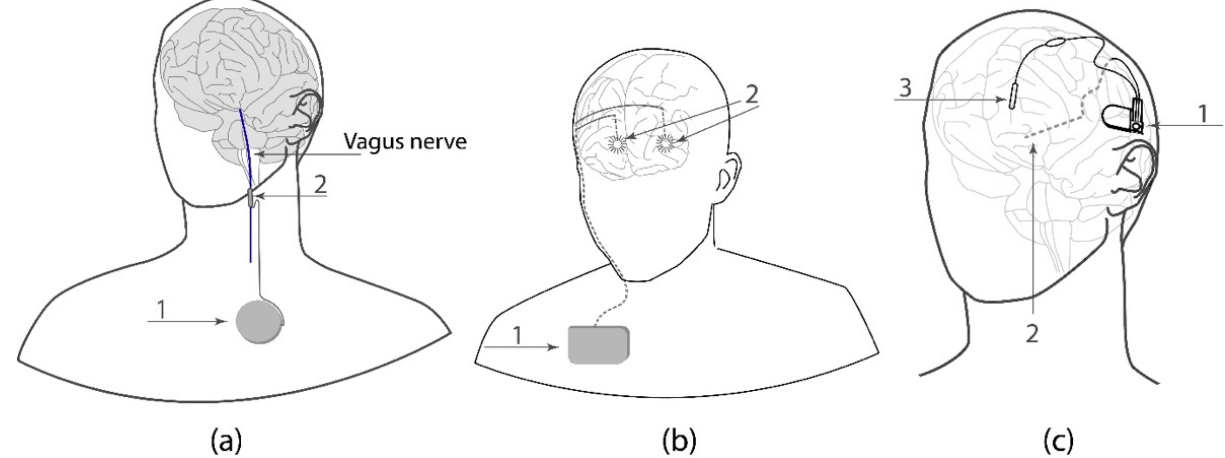
Figure 1. The schematic illustration of brain-machine interface prototypes to suppress epileptic seizures using electrical stimulation. (a) Vagus nerve stimulator containing (1) an implantable pulse generator and (2) a stimulation lead. (b) Stimulator of the anterior nucleus of the thalamus in epilepsy containing (1) an implantable pulse generator and (2) intracranial electrodes placed in the anterior thalamic nuclei bilaterally. (c) Responsive neurostimulator containing (1) implanted deep electrodes for recording electroencephalography signals, (2) an implantable device for processing electroencephalography signals from electrodes, and (3) strip electrodes receiving an electrical stimulation signal generated by the device to stop